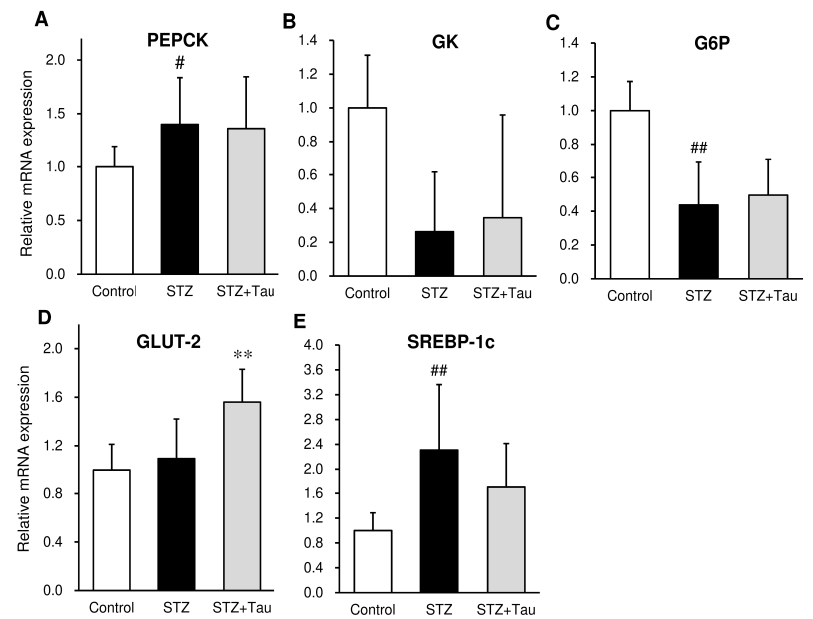
Figure 4. Effects of taurine supplementation on the mRNA expression of glucose metabolism-related genes in the liver of diabetic mice. Total RNA was extracted, and the mRNA expression was assessed using RT-PCR. ( A ) Phosphoenolpyruvate carboxykinase (PEPCK), ( B ) glucokinase (GK), ( C ) glucose- 6-phosphatase (G6P), ( D ) glucose transporter-2 (GLUT-2), ( E ) sterol regulatory element-binding protein 1c (SREBP-1c). Each value is expressed as the mean ± S.D. ( n = 4), # p < 0.05, ## p < 0.01 vs. Control group, ** p < 0.01 vs. STZ